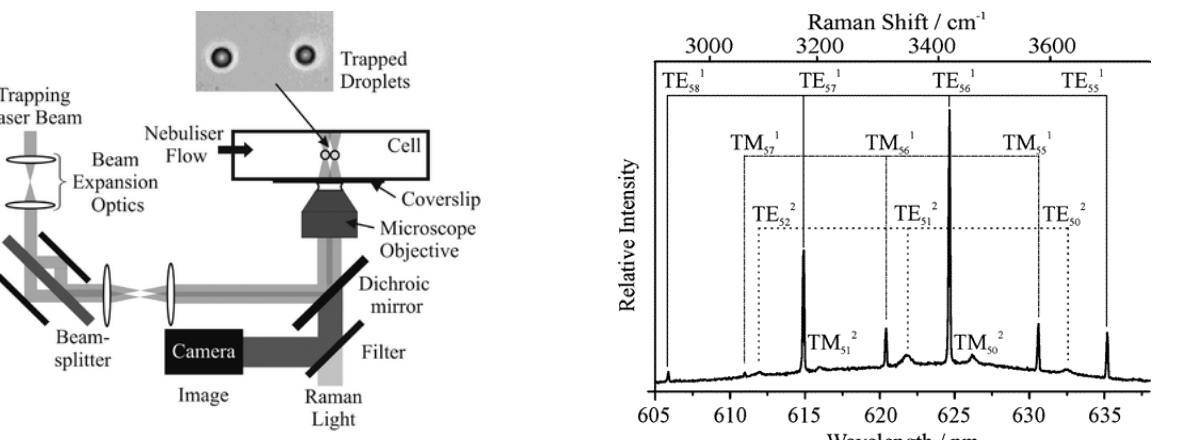
Figure 18. An example of Raman scattering from a trapped wa- ter droplet, illuminated at 514.5nm. Stimulated Raman scattering is observed at wavelengths commensurate with whispering gallery modes. The resonant modes can be assigned by comparison with Mie scattering calculations, and the droplet radius can then be de- rived. Reprint with permission by Mitchem et al. (2006a). Copyright 2006 American Chemical